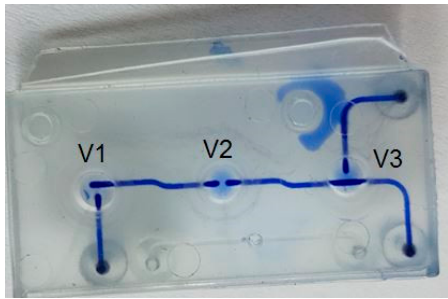
Figure 3. Doormat type microfluidic valves prepared by UV/ozone assisted bonding of injection molded COC and eCOC based microfluidic